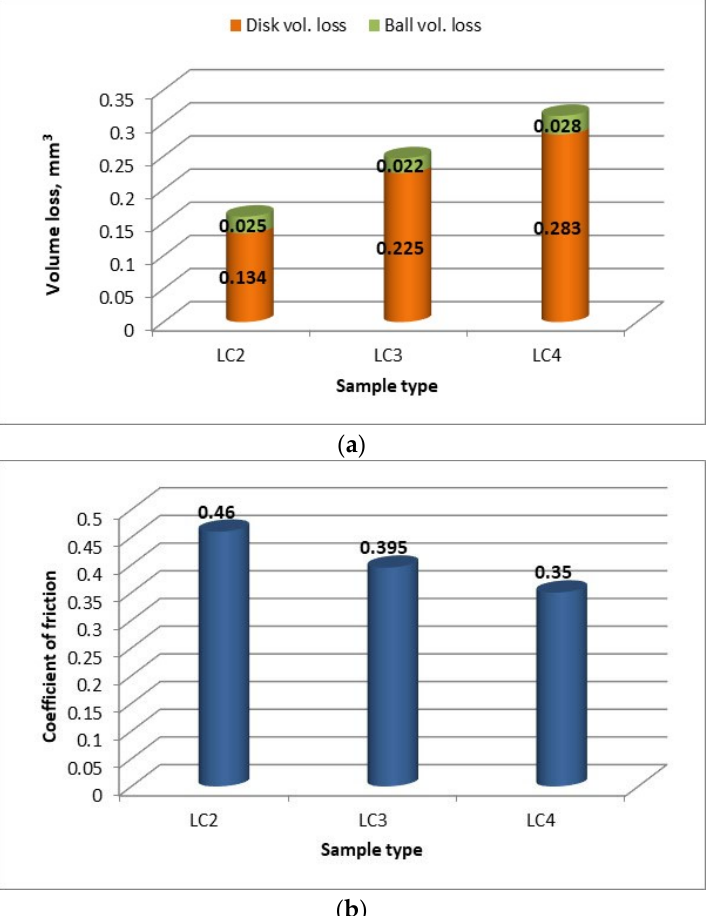
Figure 14. Volume loss of the counter body steel ball and the disc specimens with coatings made by laser cladding of NiCrBSi/WC + W 2 C powder with different processing parameters (Table 3) after sliding for a distance of 188.4 m at a normal load of 30 N ( a ); and comparison of the coefficient of friction of the disc specimens sliding with a steel ball during ball ‐ on ‐ disc wear tests ( b ).